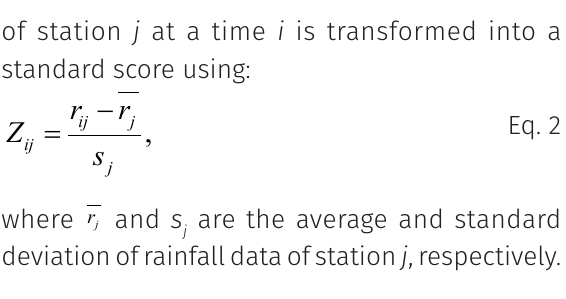
Figure 1. The geographic location of the study area and distribution of rainfall gauge